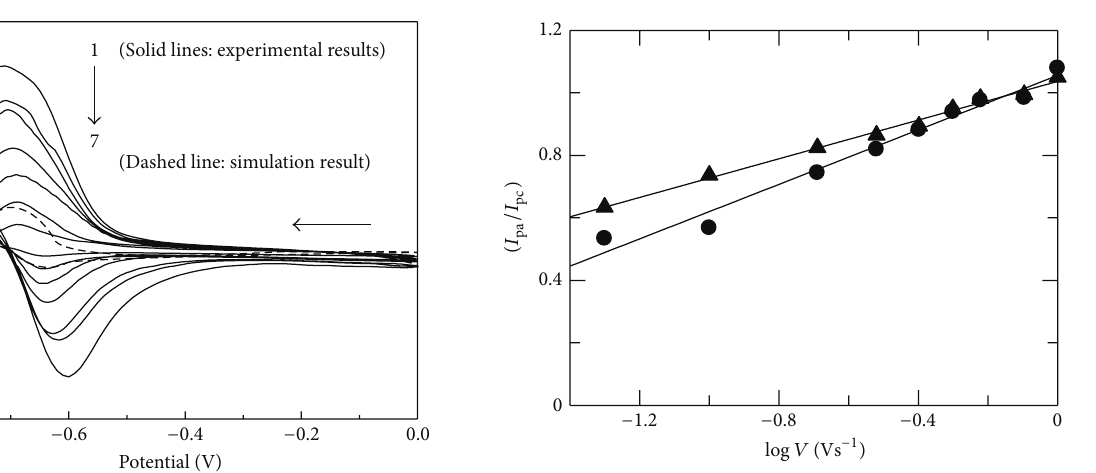
Figure 3: Plot of the ratio of anodic to cathodic peak current Figure 2: Cyclic voltammograms ( solid lines 1–7 ) of doxorubicin /𝐼 ) versus the logarithm of scan rate (log v ) for the reduction ( 𝐼 pa pc hydrochloride in aqueous buffer at pH 7.4 on glassy carbon elec- of doxorubicin hydrochloride in aqueous buffer at pH 7.4 on glassy trode. [Doxorubicin hydrochloride] = 33 𝜇 M and [NaCl] = 160mM. carbon electrode in the absence ( e ) and presence ( 󳵳 ) of 20 𝜇 M of Scan rates = 1Vs −1 (Curve-1), 0.5 Vs −1 (Curve-2), 0.4 Vs −1 (Curve- CT 3), 0.3 Vs −1 (Curve-4), 0.2 Vs −1 (Curve-5), 0.1Vs −1 (Curve-6), and 0.05 Vs −1 (Curve-7), temperature = 25 ∘ C. Dashed line: simulation result. Simulation parameters: 𝑘 𝑠 = 0.03 cm s −1 ; 𝛼 = 0.5 ; 𝐸 = = 3 × 10 −5 , −0.675 V (versus Ag/AgCl, saturated KCl, 0.199 V); 𝐷 0 6.0×10 −5 , 1.0×10 −5 cm 2 s −1 for doxorubicin hydrochloride, quinone dianion, and semiquinone, respectively; and electrode area 𝐴 = = 10 × 10 3 and 𝑘 = 4 × 10 2 for the homogeneous 0.1256 cm 2 . 𝑘 𝑓 𝑏 chemical reaction (Scheme 1).